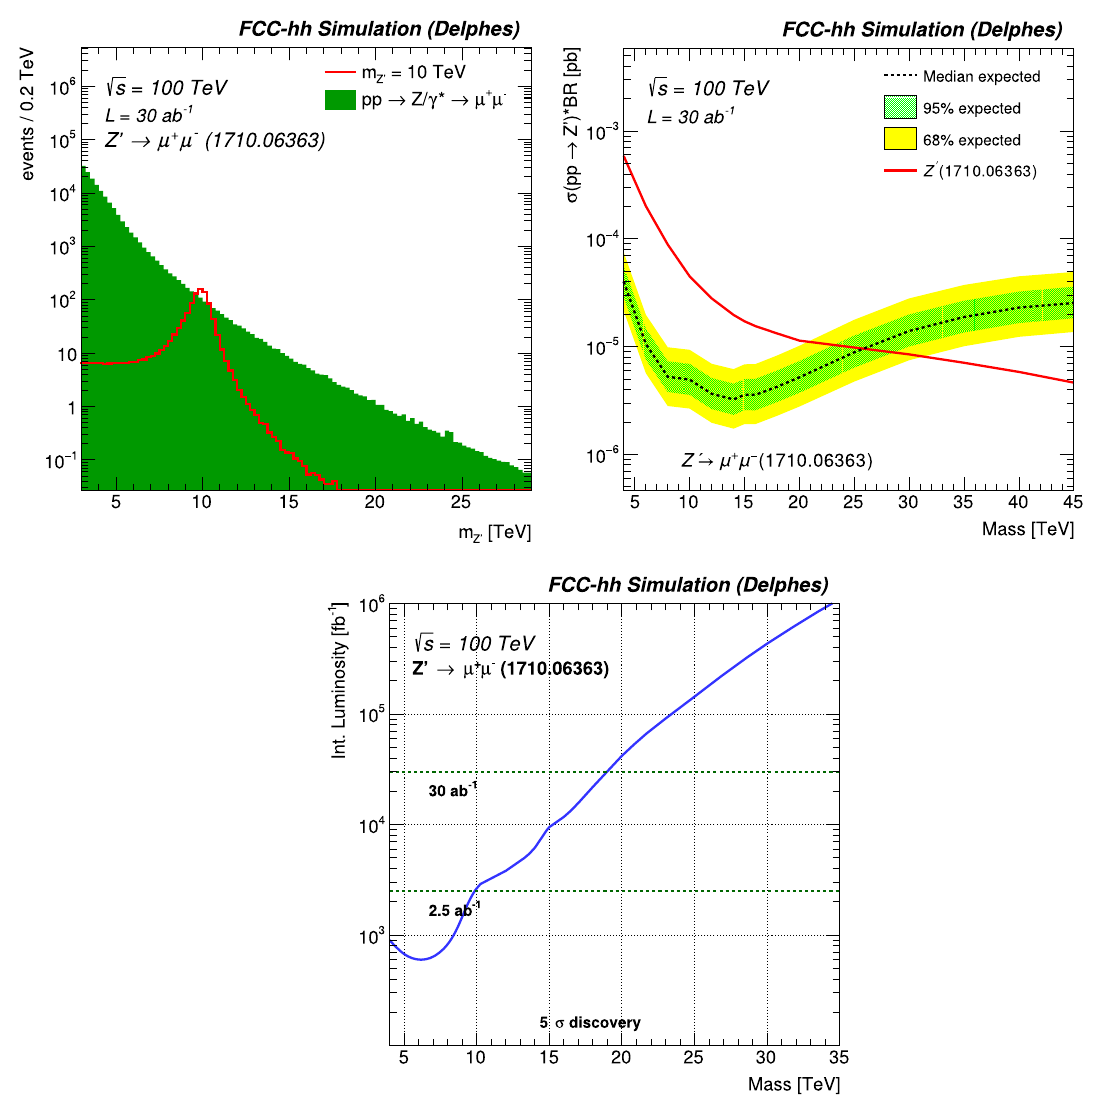
Fig. 5 Left: invariant mass for a 10 TeV signal after full event selection in flavour anomaly scenario. Limit versus mass (right) and luminosity for a 5 σ discovery